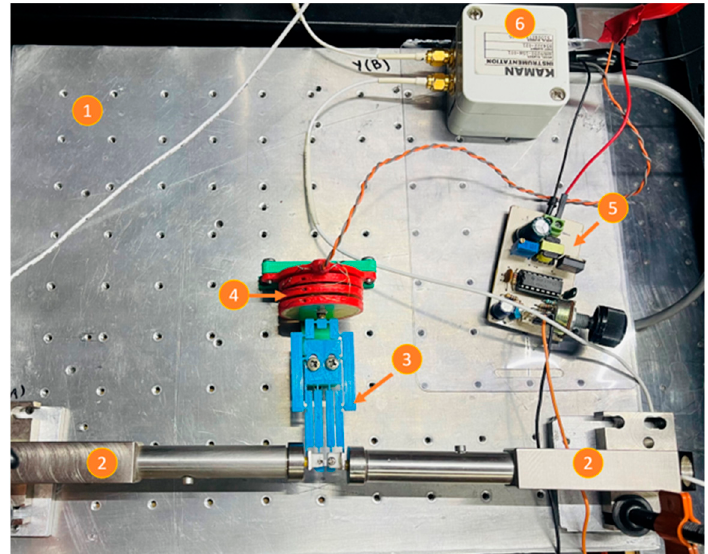
Figure 18. Experimental setup to characterize the piezoelectric stack-driven MG.